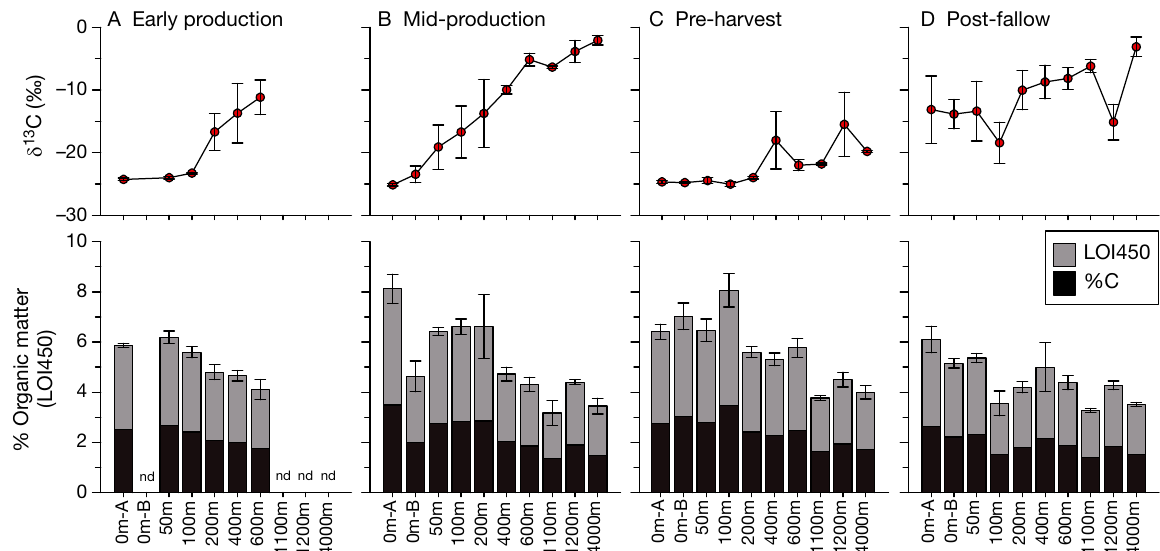
Fig. 5. δ 13 C in sediments and sediment organic matter (determined as the weight loss after ignition at 450°C, LOI450) and % carbon of sediments. Error bars represent ±1 SE; nd: no